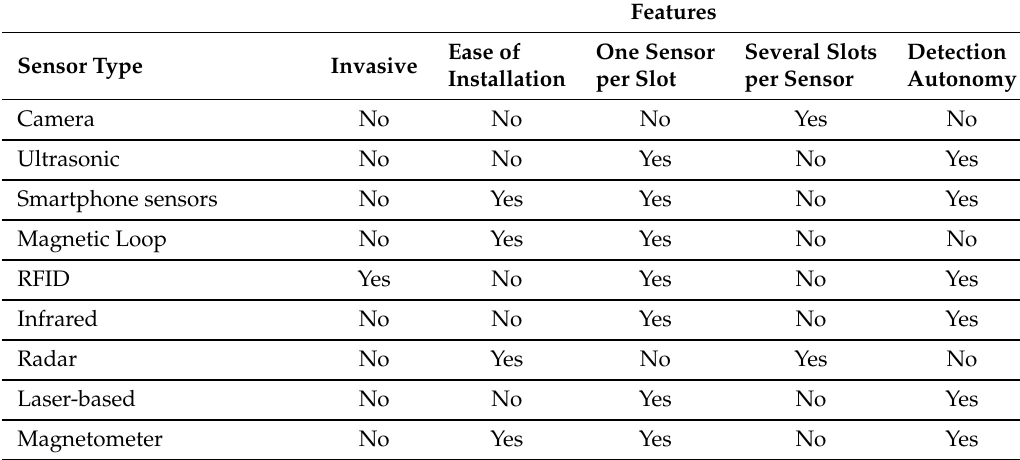
Table 6. Sensor selection